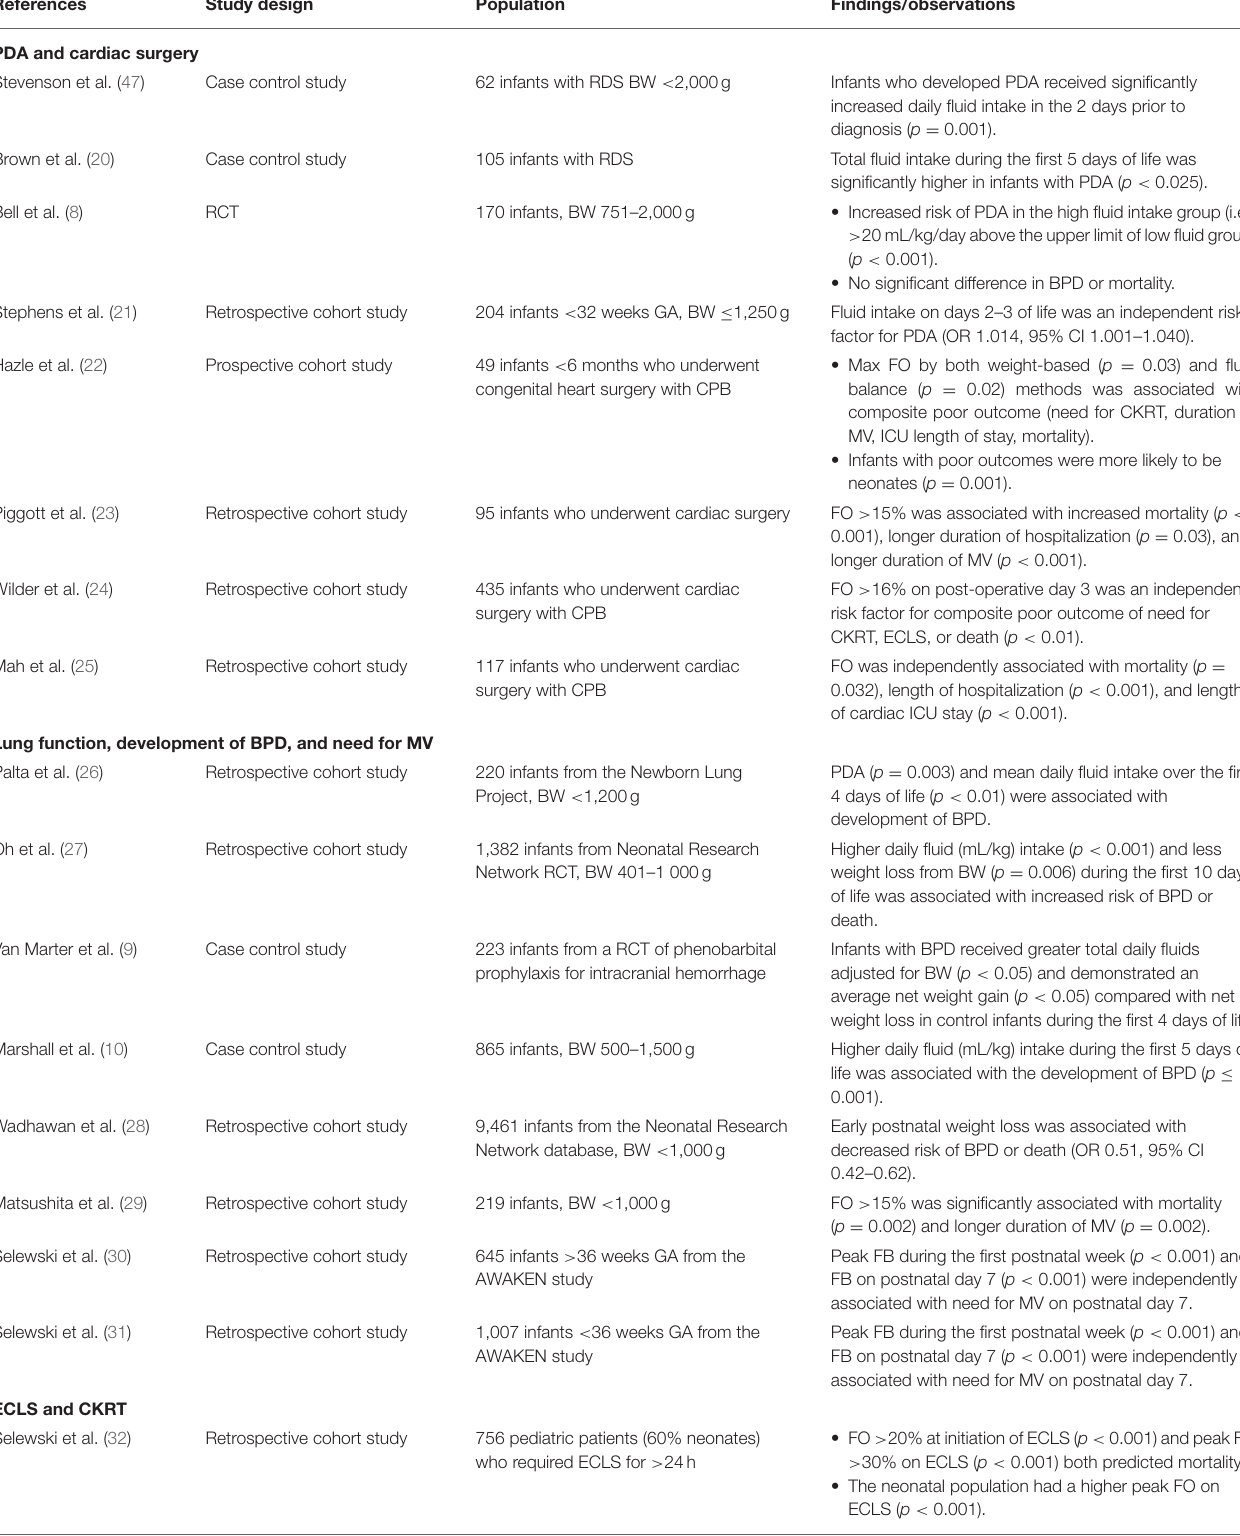
TABLE 1 | Impact of fluid intake, FO, and weight loss on outcomes in